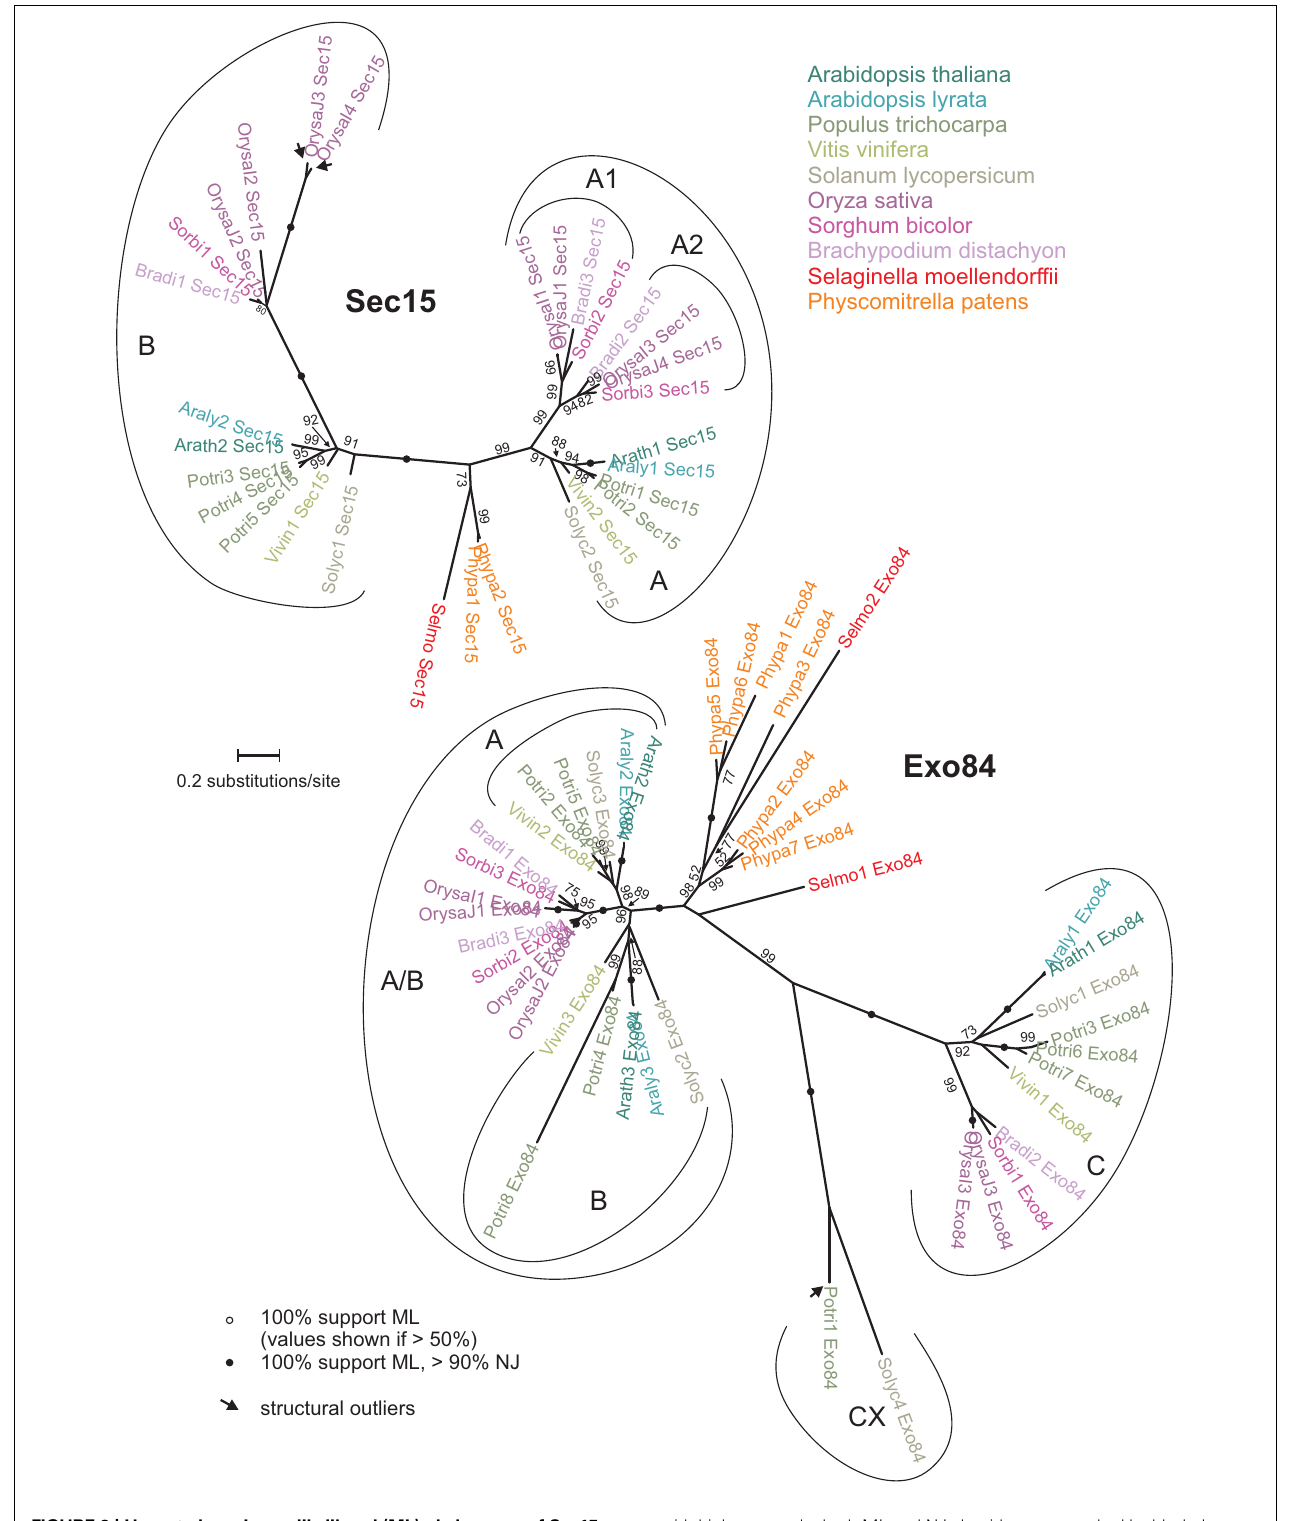
FIGURE 2 | Unrooted maximum likelihood (ML) phylograms of Sec15 and Exo84. All SH-like support values above 50% are shown. Consistent trees were obtained also using the neighbor-joining (NJ) method;